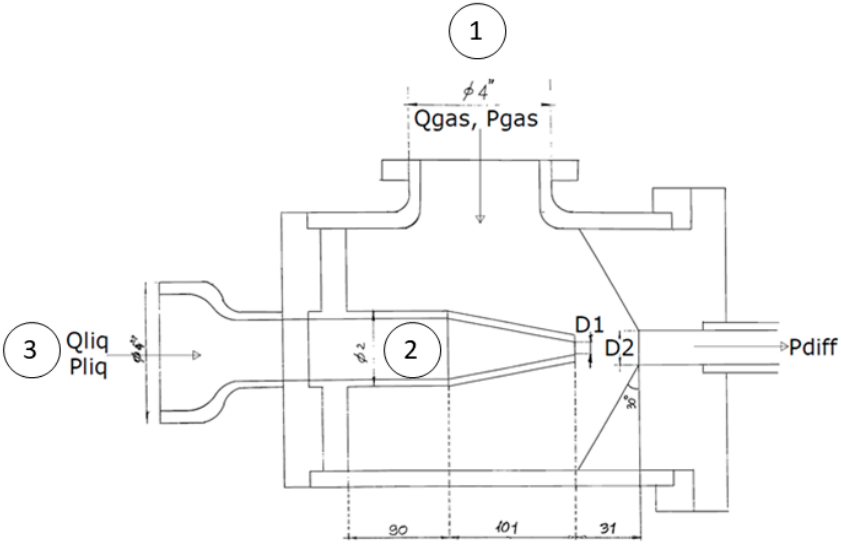
Figure 4. The ejector scheme. (1) Identifies the suction mouth of the fluid sucked in; (2) the converging nozzle, where the pressure is reduced, and the speed of the motor fluid is increased by the Venturi effect; and (3) the inlet port of the motive fluid.